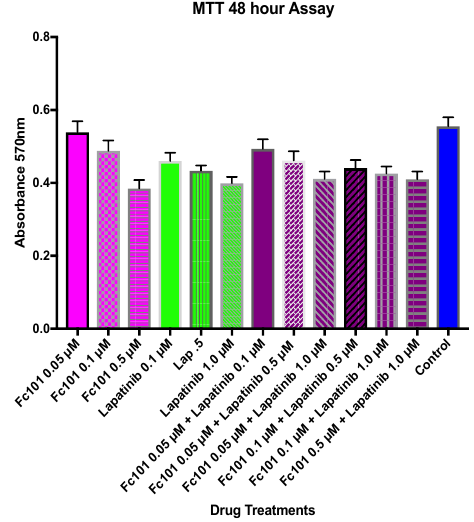
Figure 4. MTT viability assay dose –response curve. FC101 (0.05 μM, 0.1 μM, 0.5 μM) and lapatinib (0.1 μM, 0.5 μM, 1.0 μM). Each concentration of FC101 was paired with an equal or higher concentration of lapatinib. The graph represents the normalized color intensity A 570 (% control) vs. each single and combination treatment at 48 h.